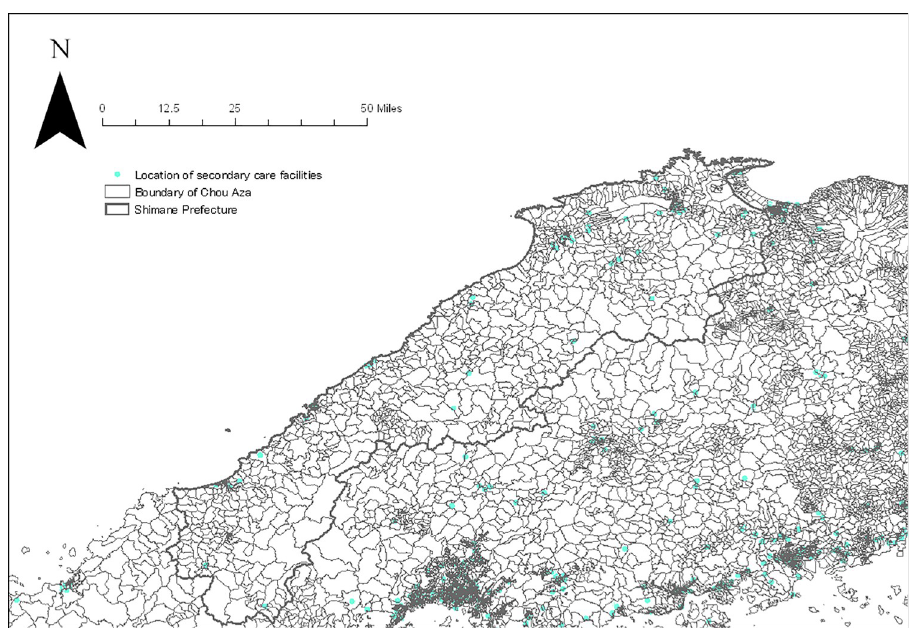
Fig 2. Location of secondary care facilities in Shimane and four peripheral prefectures.